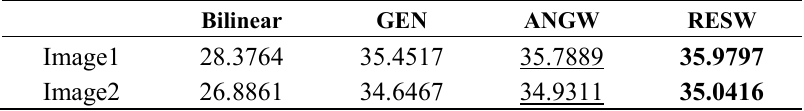
Table 3. PSNR comparisons of the reconstruction results in the simulation image data